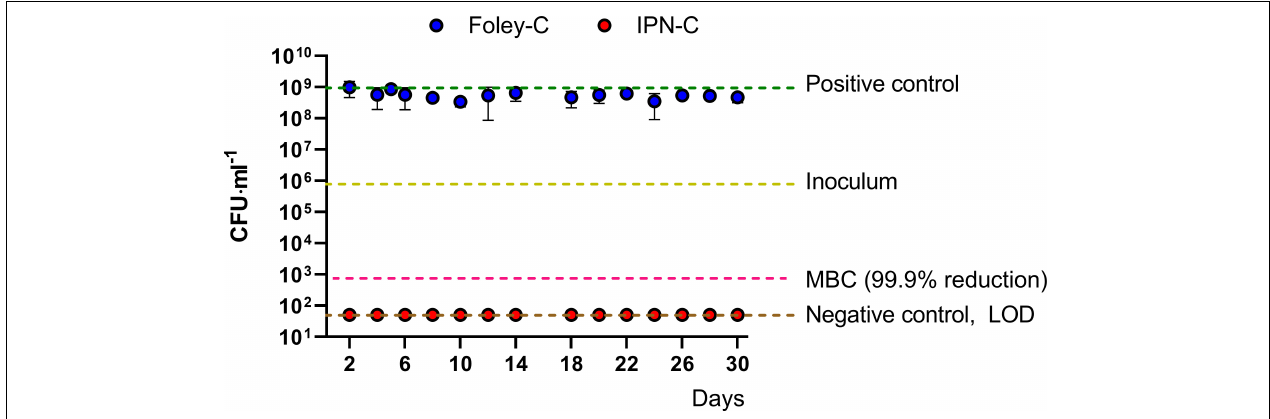
FIGURE 4 | Functional release assay. Standard Foley catheters and interpenetrating polymer network (IPN) catheters were loaded with 8 ml of sparfloxacin 50 µ g ml − 1 and submerged into 1 L of sterile NaCl solution. Samples were collected from the media every other day after which the media was changed. Aliquots were inoculated with UTI89 and incubated ON to evaluate antibacterial activity. The suspensions were plated to quantify viable bacteria. Media retrieved from bottles with Foley catheters (blue dots) did not prevent bacterial growth as CFU reached levels similar to the positive control (saline + inoculum, green line). In contrast, no viable bacteria were detected in media from bottles with IPN catheters (red dots) for the monitoring period of 30 days. Data represents means ± SD from three independent experiments. MBC, minimum bactericidal concentration; LOD, limit of detection (50 CFU ml − 1